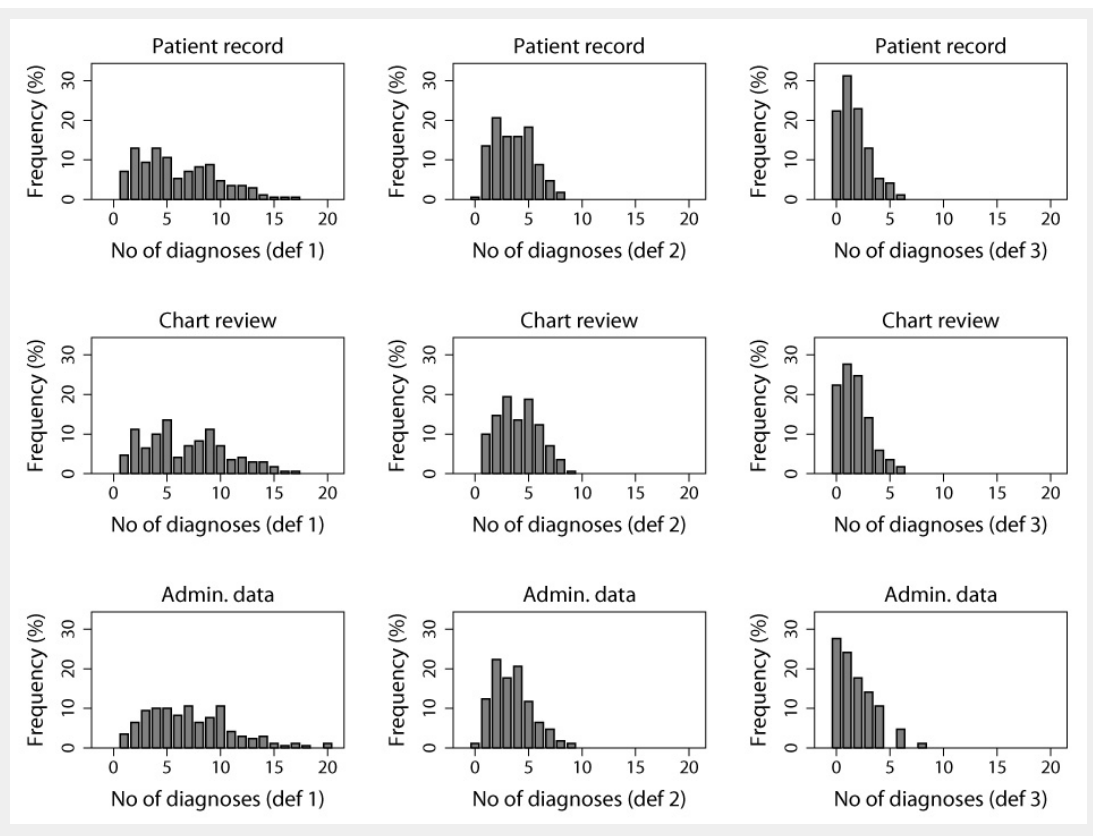
Figure 2 Frequency distribution of the number of diagnoses per patient based on three different data sources (rows) and three different definitions of multimorbidity (columns). The first column represents the frequency distribution of the number of diagnoses from the ICD-10 disease classification system within one patient (def 1). The second column represents the frequency distribution of the number of diagnoses from different organ-specific chapters of the ICD-10 classification system within one patient (def 2). The third column represents the frequency distribution of the number of diagnoses within one patient as defined by the Charlson/Deyo comorbidity index (def 3). Data sources for the first row are patient records (notes as cited by the treating physician), for the second row comprehensive chart reviews (two medical residents reviewed physician’s notes, medical charts, imaging and laboratory tests and appended diagnosis not mentioned in patient’s records), and for the third row administrative hospital discharge data (generated by a professional hospital coding team within 30 days of patient discharge from the hospital). The frequency distribution of the number of diagnoses within one patient is mainly determined by the definition of multimorbidity and not by the data source